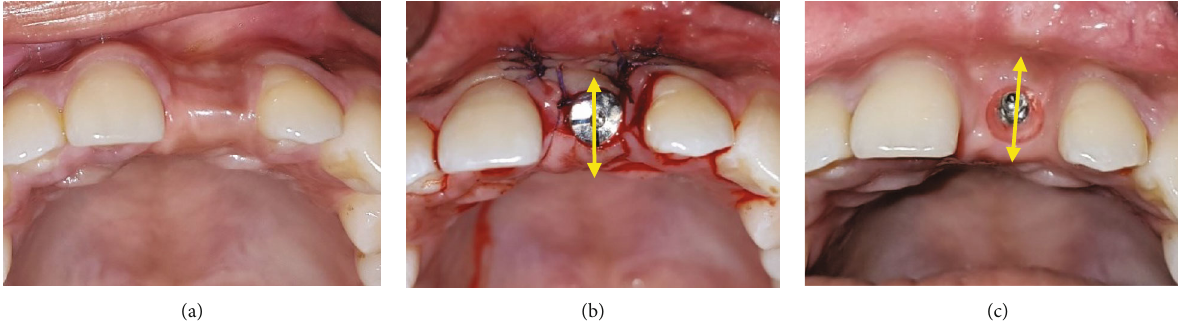
Figure 1: The measurement of augmented tissue resorption. (a) Postextraction horizontal defect of 21 alveolar ridge prior to augmentation; the tissue resorption is established by measuring clinically the di ff erence in alveolar width between the immediate post augmentation procedure (b) and the follow-up at the end of the study period (c). The data collected is subsequently categorized into tissue resorption